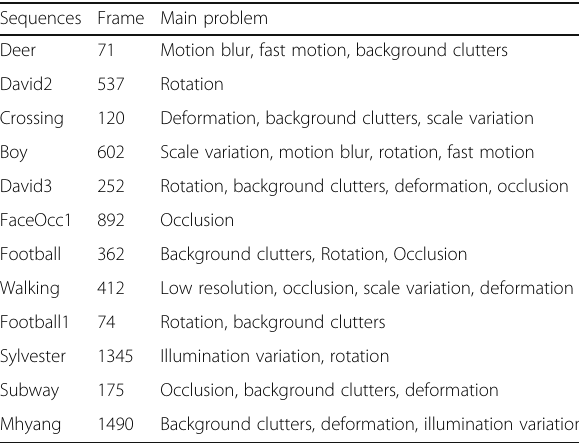
Table 1 Tracking sequences used in this